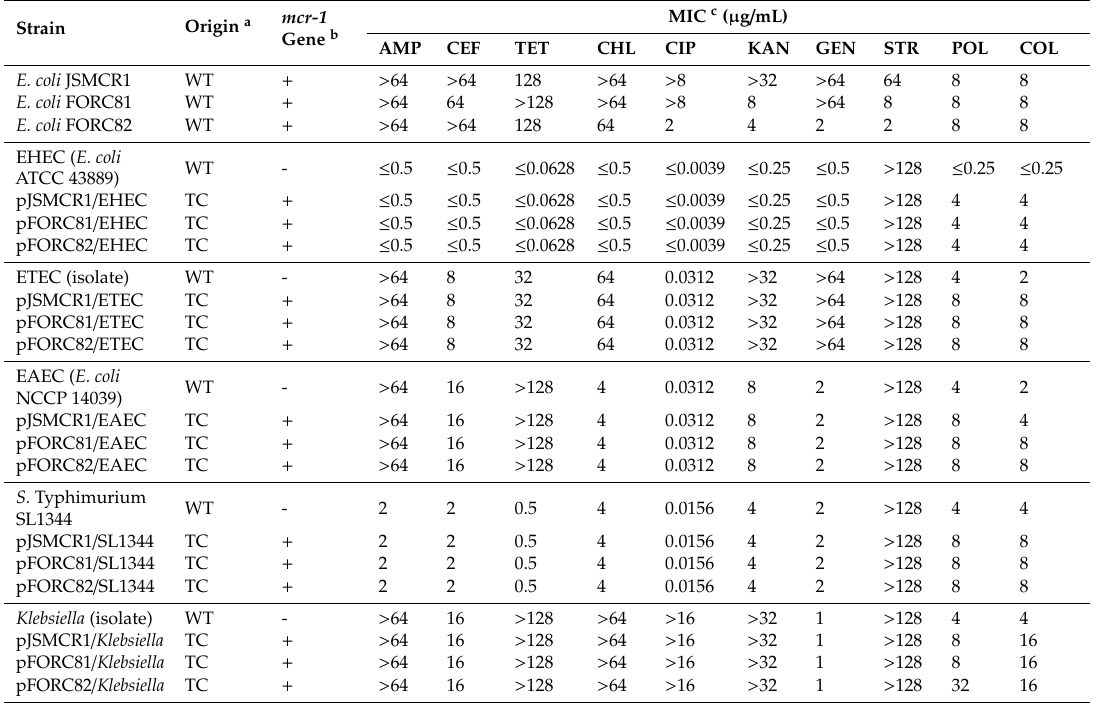
Table 2. Minimum inhibitory concentrations (MICs) of mcr-1 -positive E. coli strains and their